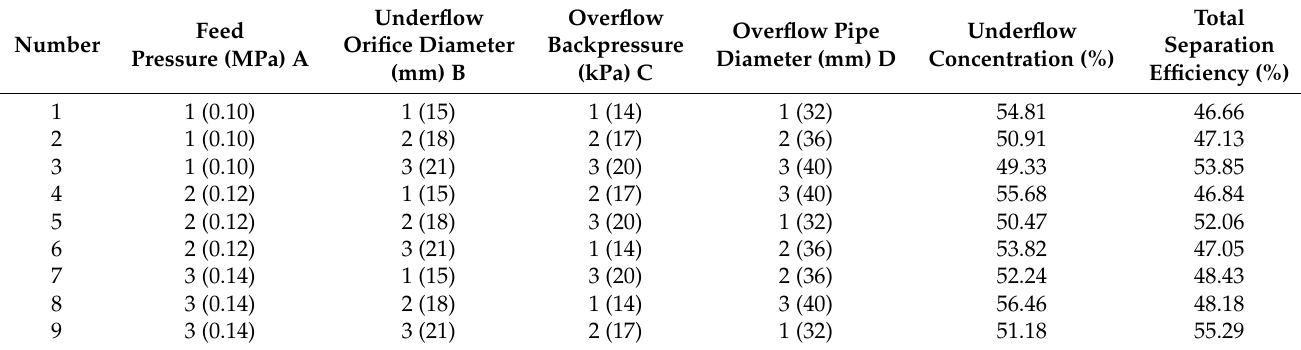
Table 11. Orthogonal test.